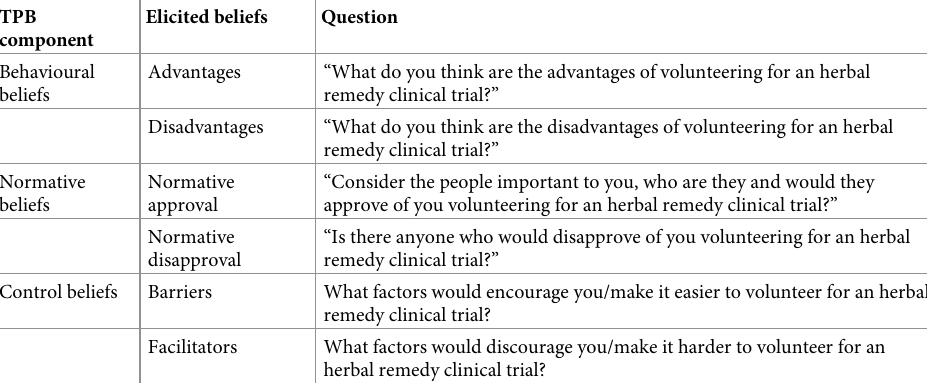
Table 1. Focus group discussion